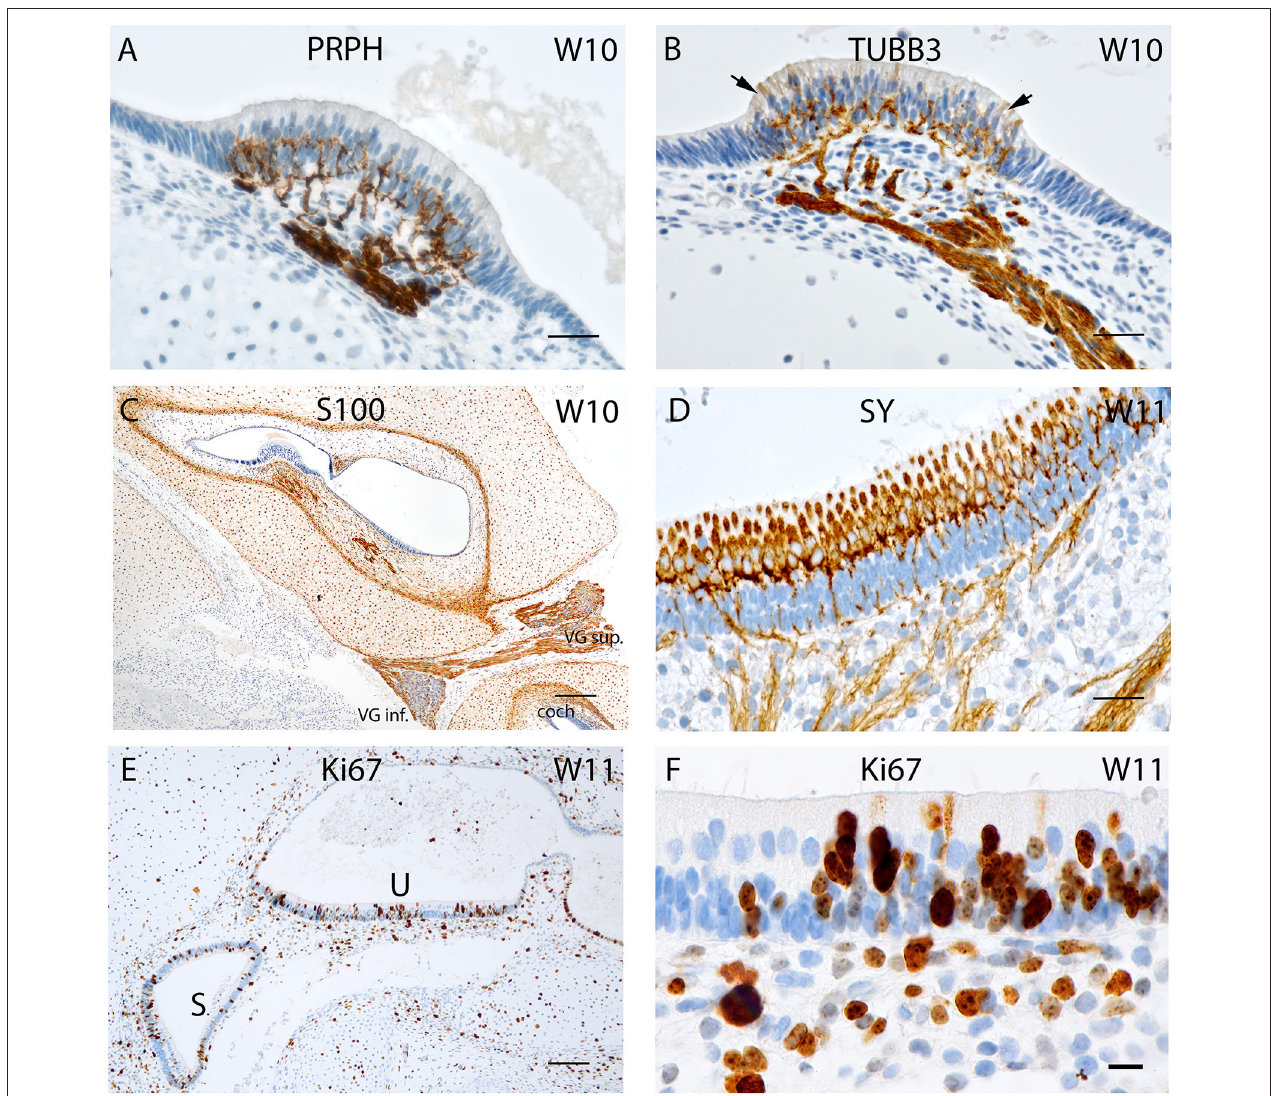
FIGURE 3 | (A) Peripherin staining of the cristae ampullaris at W10. The staining pattern is similar to that seen in W8 with the positive fibers extruding into the basal portion of the sensory hair cells. (B) Beta III tubulin staining in a crista ampullaris. Strong immunoreactivity in the nerve fibers. (C) S100 staining is present in all cell types except neurons and otic epithelium lining the vestibulocochlear duct. At the transition between otic capsule and mesemchymal stroma pronounced immunoreactivity delineates the later borders of the bony labyrinth. (D) Synaptophysin immunoreactivity deepens at W11 in the nerve fibers reaching the sensory cells of the utricle where the hair cells express SY while the supporting cells do not. (E) Ki-67 immunostaining in the proliferating cells of the macular organs at W11 (U, utricle; S, saccule). (F) Ki-67 expression is visible in the basal cell layer of the utricular epithelia as well as in the intermediate and apical region of the epithelium that could be hair cells. Scale bar: 12 µ m (A,B,D) , 10 µ m (F) , 50 µ m (C,E)